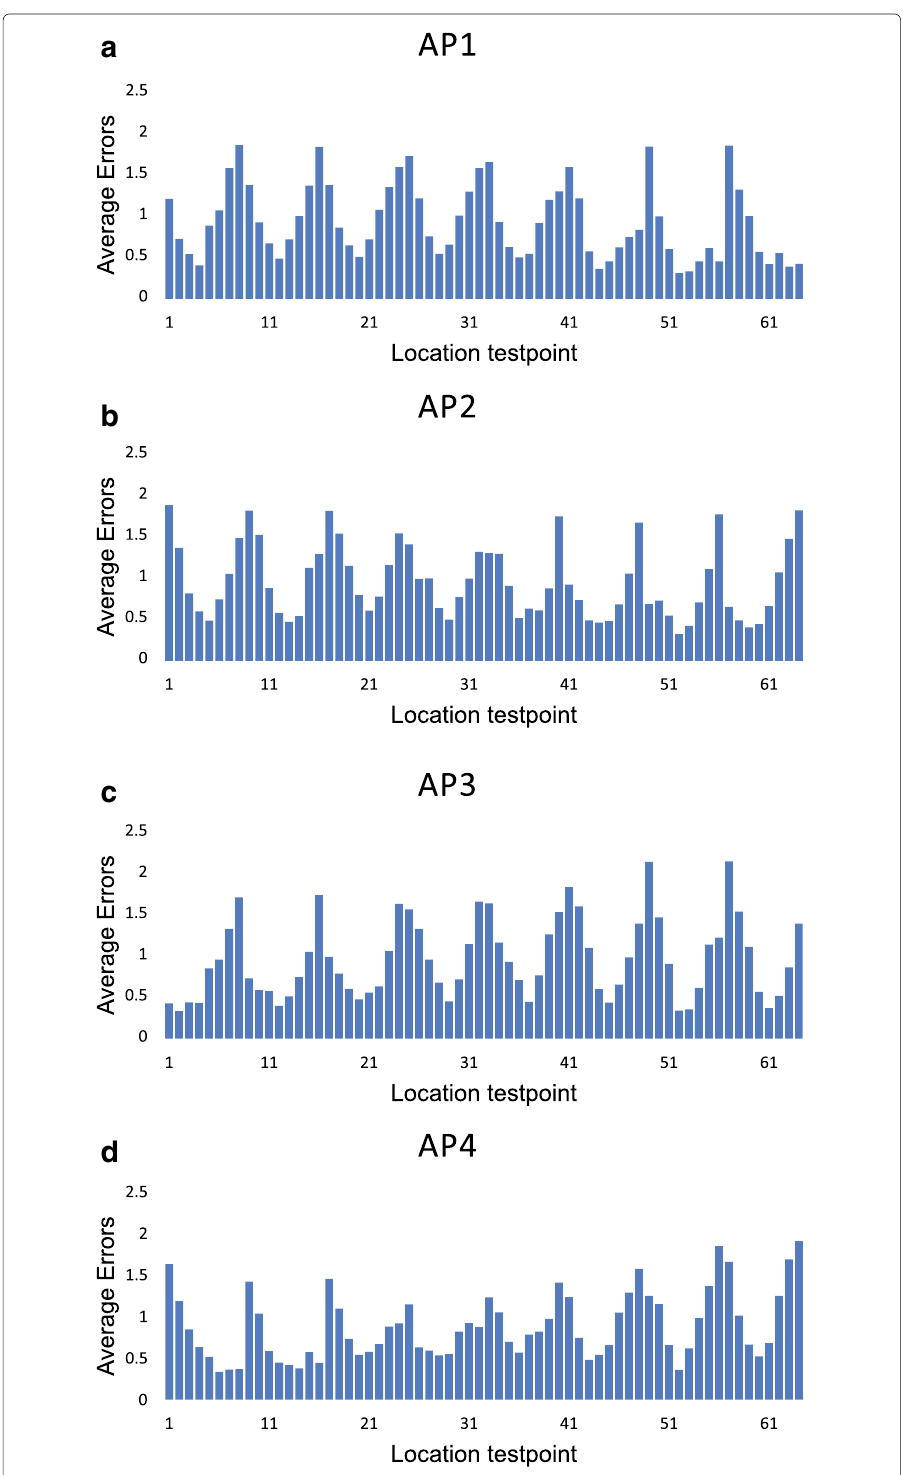
Fig. 14 The average errors of location test